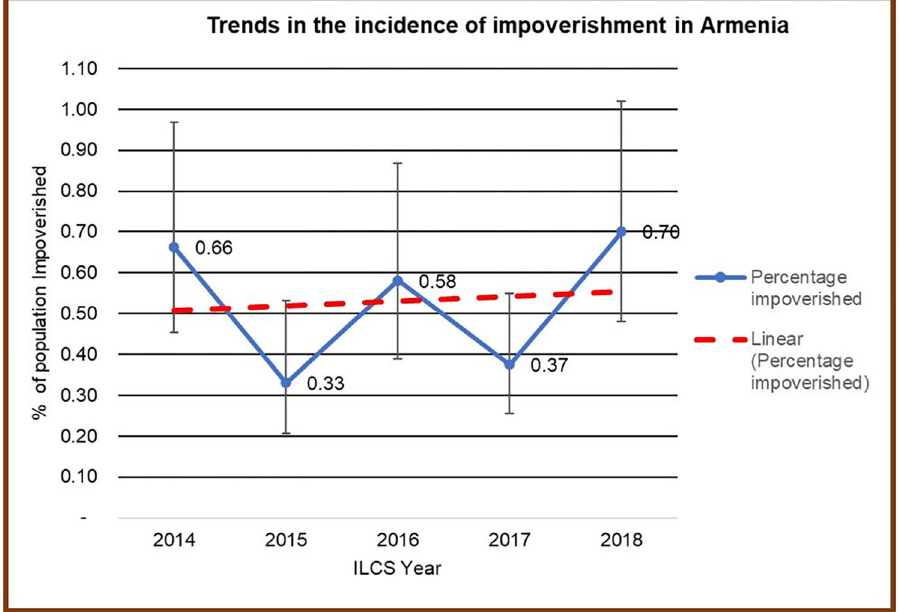
Fig 1. Trends in impoverishment in Armenia between 2014 and